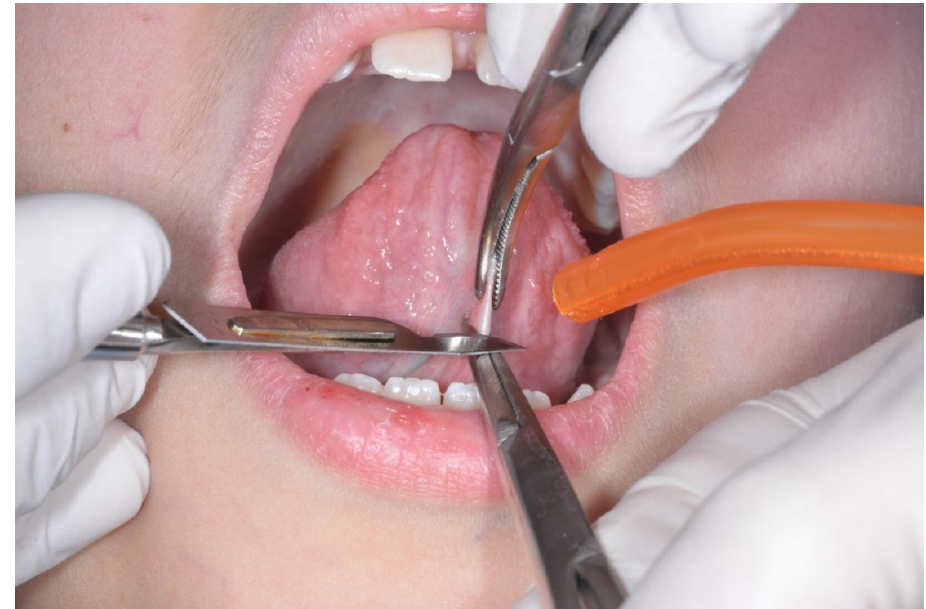
Figure 1. Clamping of the frenulum using two hemostatic forceps. The surgeon used a scalpel with a n15c blade to perform the section of the frenulum (Figure 2).